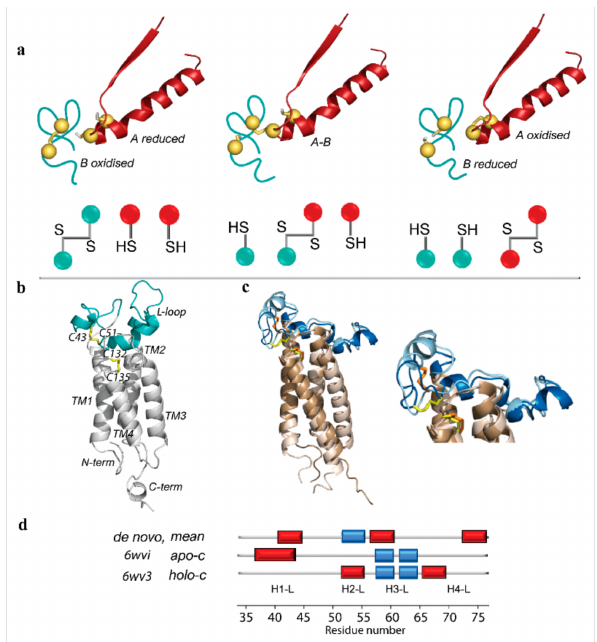
Figure 1. Thiol–disulfide exchange reactions between PDI and hVKORC1. ( a ) Thiol–disulfide exchange reactions involve reduced (proton-coupled) PDI ( A , in red) and oxidised hVKORC1 ( B , in deep teal). Generation of mixed-disulfide intermediate A - B involves an in-line transition state. Mechanistic models (top panel) and simplified scheme (bottom panel) of states A , A - B, and B show a reduction of pair of cysteine residues of oxidised protein ( A , hVKORC1) by a CX 1 X 2 C dithiol motif ( B , PDI). ( b ) Three-dimensional de novo models of hVKORC1 in the oxidised inactive state (left, [14]). ( c ) Superimposed crystallographic structures characterising the oxidised state of VKOR- like protein from Takifugu rubripes (free-ligand) (6wvi) and hVKORC1 with ligands (warfarin and glycerol monooleate) (6wv3), referenced as apo-c (light blue) and holo-c (dark blue) forms (middle), with a zoomed view on the L-loop (right). Ligands are not shown for clarity. ( b , c ) Protein and its fragment are shown as ribbons; disulfide bridges denoted in yellow and orange sticks. TMD helices coloured in grey ( b ) and brown ( c ). ( d ) Interpretation of L-loop secondary structure in the de novo model (mean conformation over cMD trajectory) and two crystallographic forms of oxidised VKOR. α - and 3 10 -helices are shown in red and blue, respectively. Helices numbering is adapted from